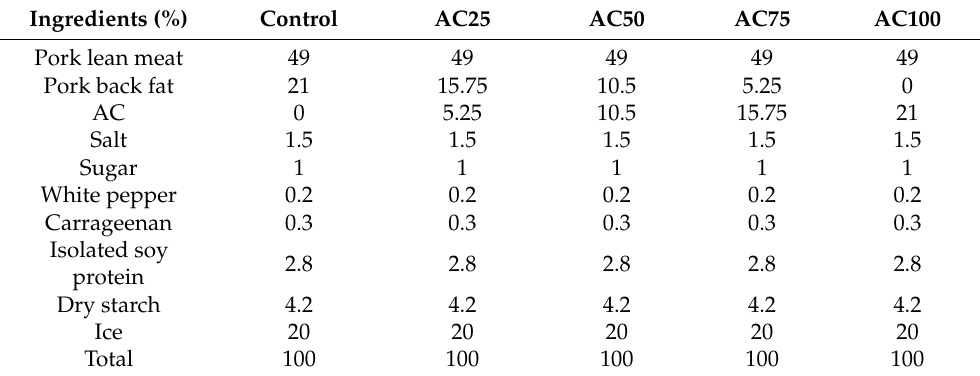
Table 1. Formulations of sausages with alternative of pork fat at Auricularia cornea (AC). Ingredients